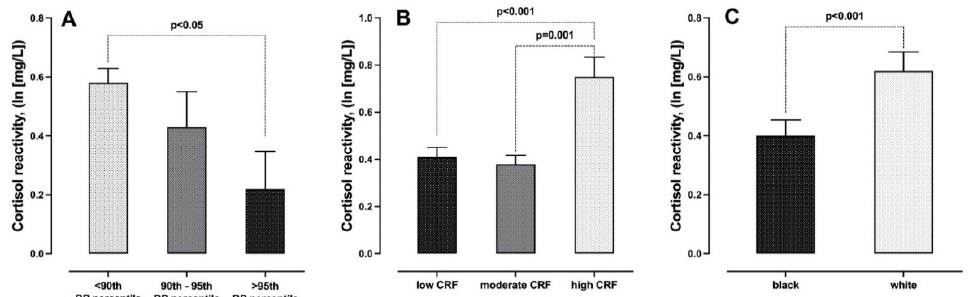
Figure 2. Comparison of cortisol reactivity in relation to ( A ) blood pressure categories, ( B ) tertiles of cardiorespiratory fitness and ( C ) black and white participants.